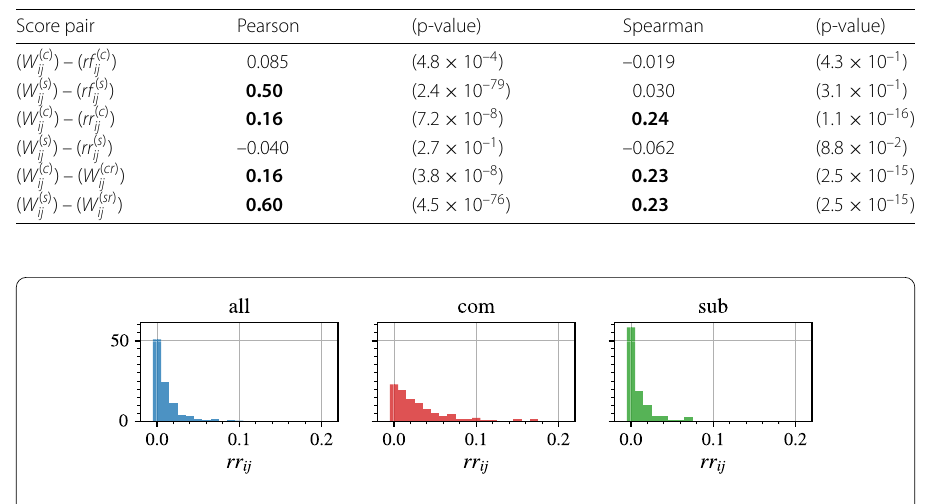
), ( W ( s ) ), and the measures from ij ij > 0 } and { ( i , j ) : W ( s ) > 0 } , respectively), ( W ( cr ) ), ( W ( sr ) ) ij ij ij ij